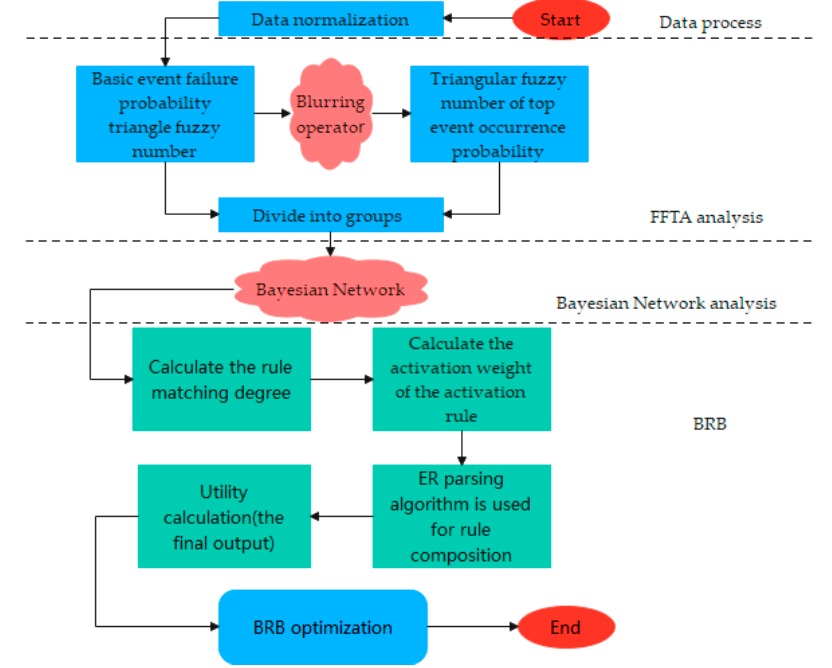
Figure 7. Diagram of FFBRB model inference process.